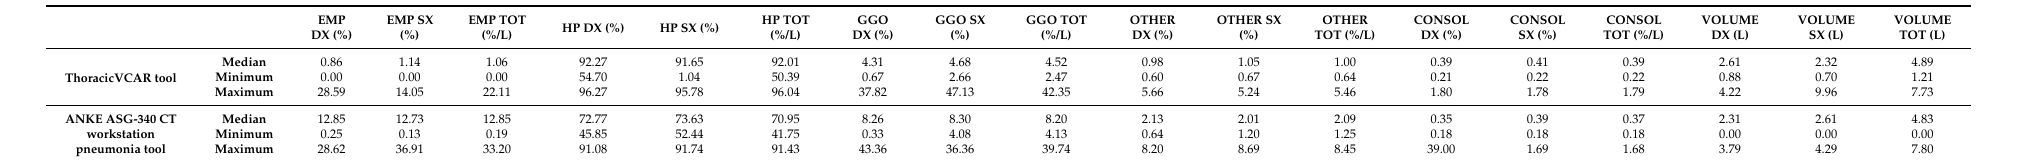
Table 8. Lung volumes quantified by two tools in terms of median, minimum, and maximum values obtained on follow-up CT